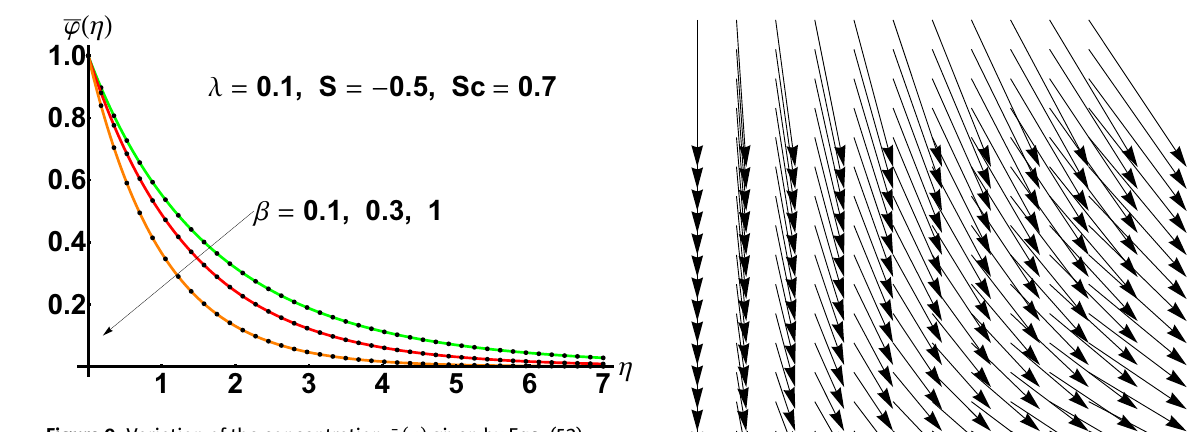
Figure 9: Variation of the concentration ¯ φ ( η ) given by Eqs. (53), (54) and (55) with increasing of the reaction rate parameter β for S = −0.5 , λ = 0.1 and Sc = 0.7 : -------- OHAM solution ; ••••••••